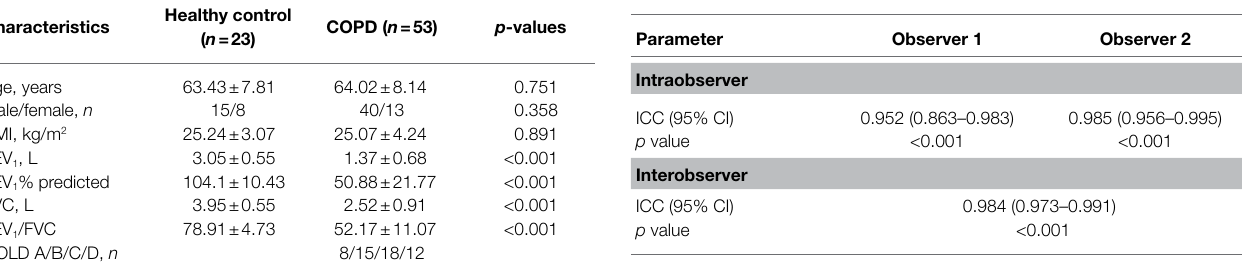
TABLE 2 | Reliability and repeatability results of the measurements performed by different